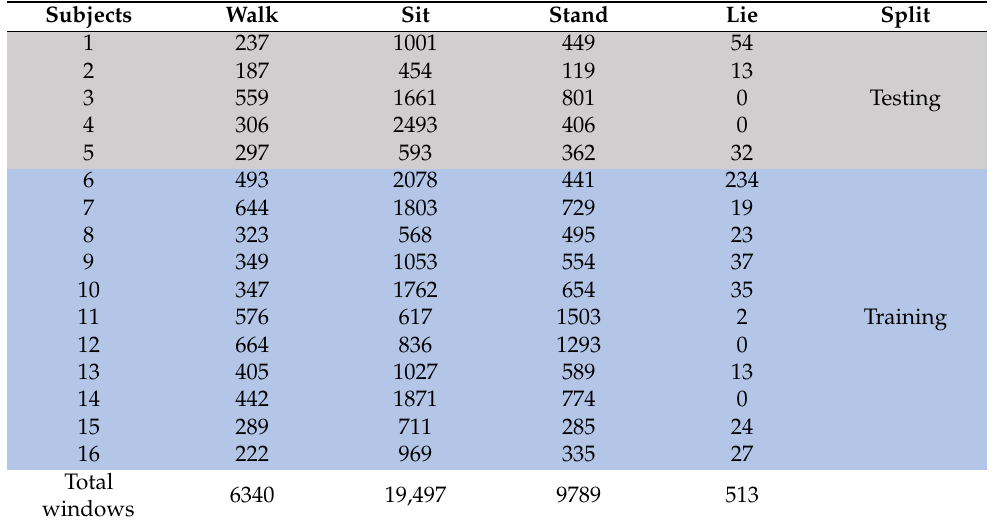
Table 1. Training and testing data split, giving the number of sample windows per participant and classified